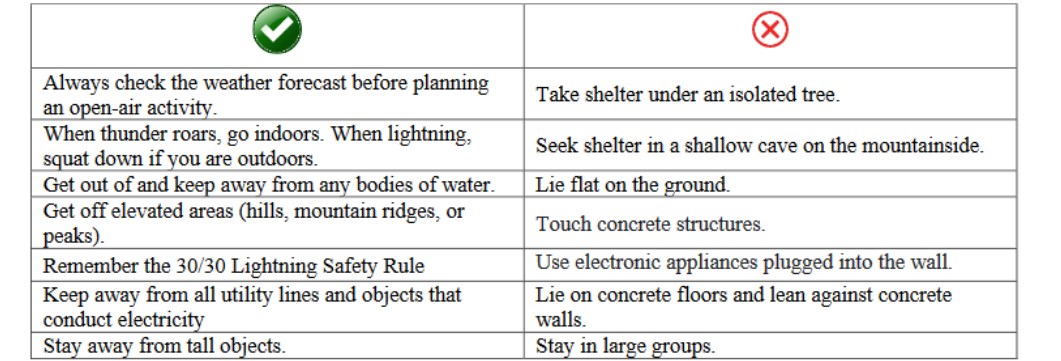
Table 3. Dos and don’ts in the case of a lightning